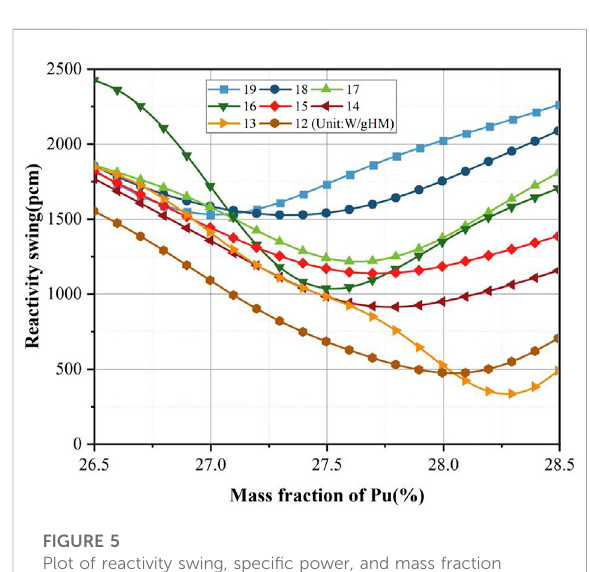
FIGURE 5 Plot of reactivity swing, speci fi c power, and mass fraction (26.5% –